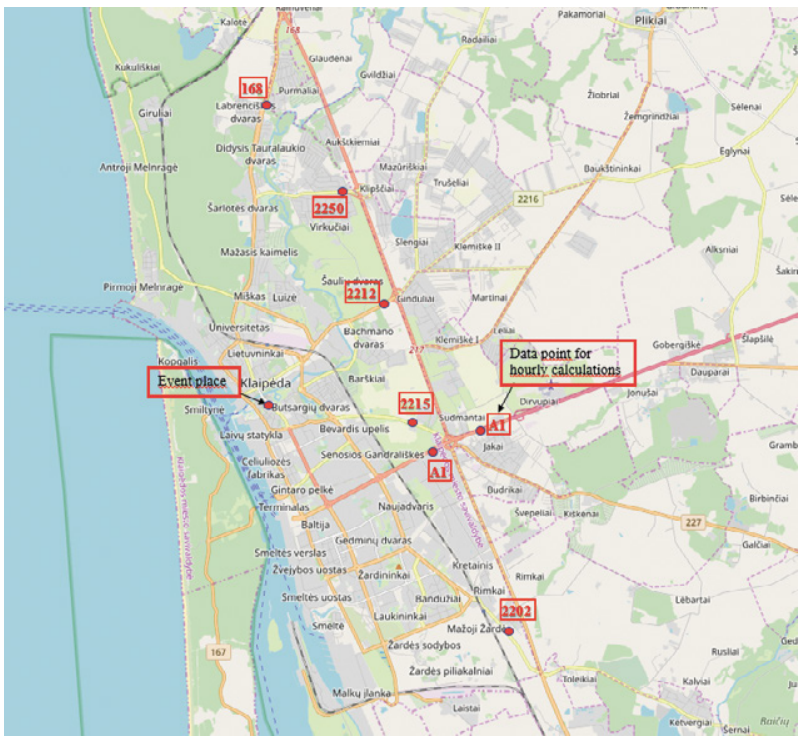
Figure 3. Data points for traffic flow volume collection